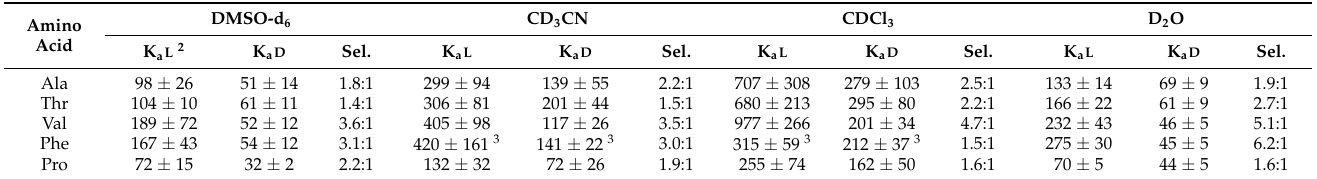
Table 1. Association constants of complexes between receptor 1 and amino acid methyl ester HCl salts 1 .